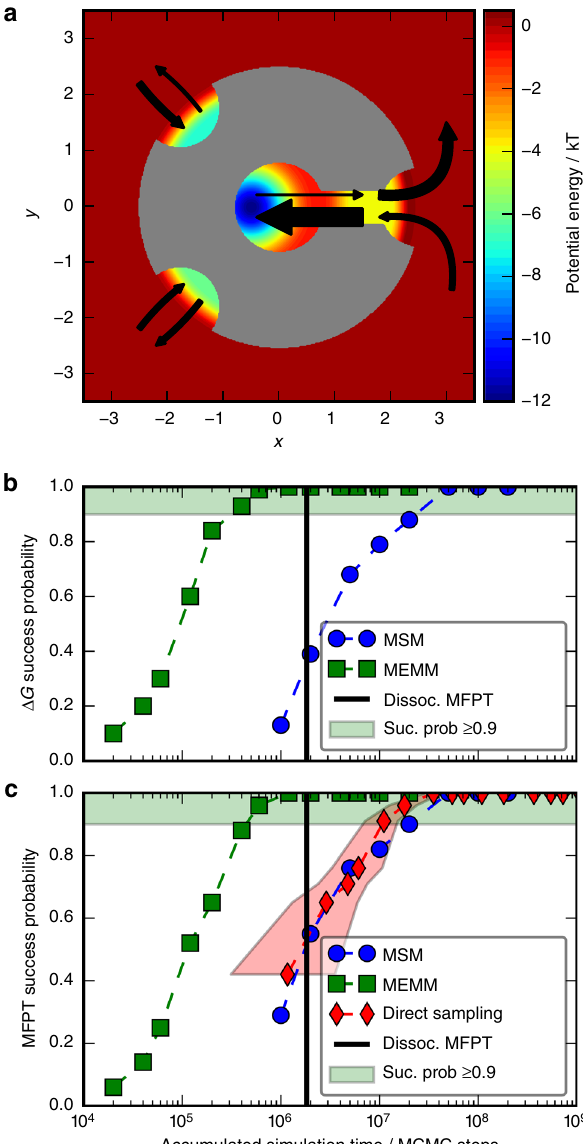
Fig. 4 Illustration of computing rare-event kinetics with TRAMMBAR using a model for protein ligand binding. a Potential energy surface and transition rates between fi ve states (bound, pre-bound, two mis-bound states, dissociated). Arrow thickness is proportional to rate. b Probability of computing the binding free energy Δ G within 1 k B T accuracy of the exact value for a given amount of simulation data using MEMMs (TRAMMBAR estimator) or MSMs. The vertical bar indicates the mean- fi rst-passage time (MFPT) for dissociation. c Probability of computing the dissociation rate within factor 1 to 2 accuracy of the exact 2